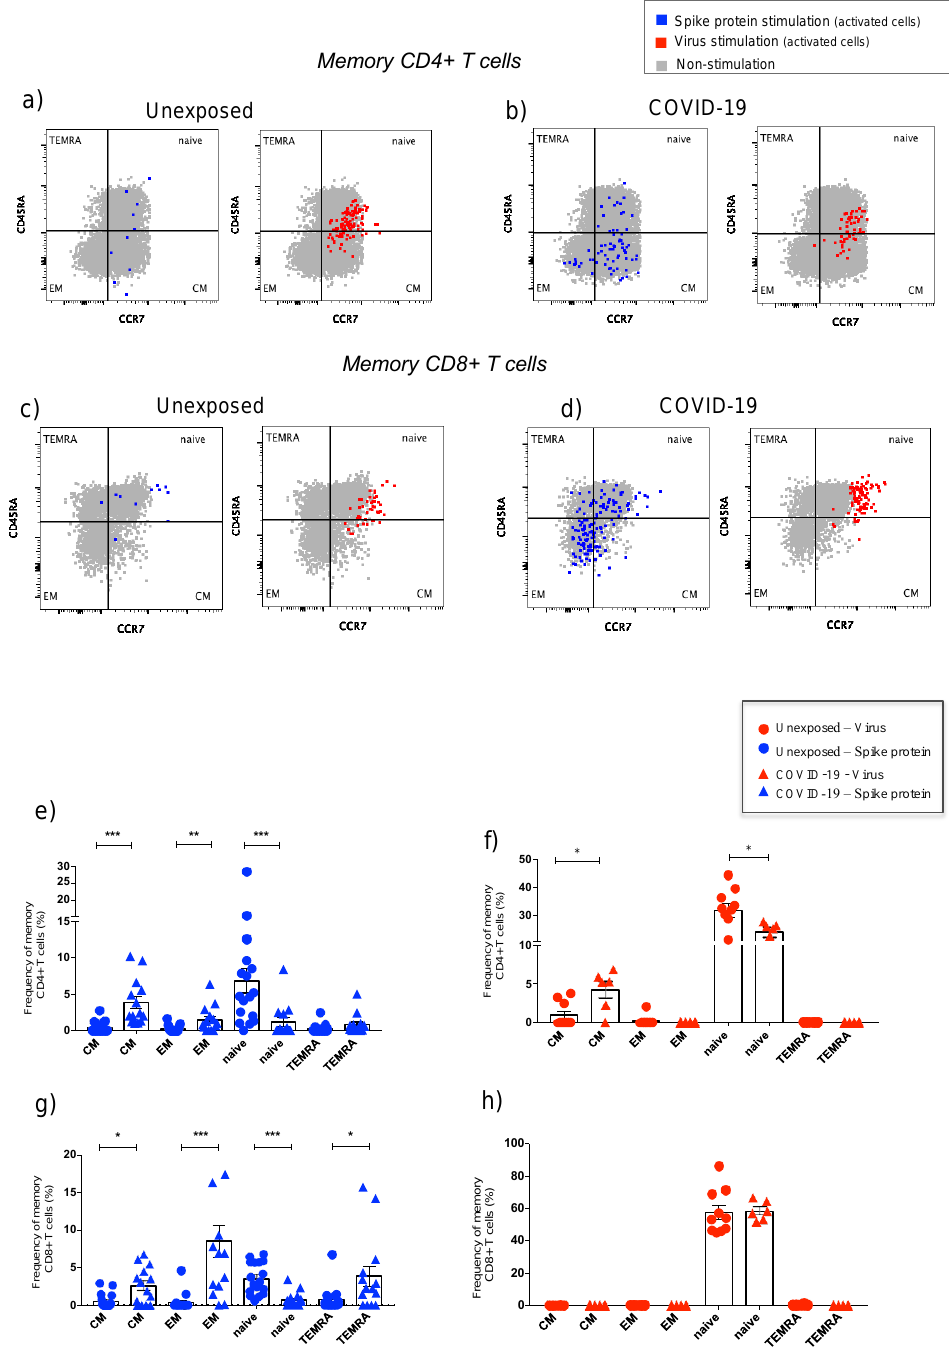
Figure 5. Memory T-cells phenotypes affected by spike protein stimulation and by live SARS-CoV-2 exposure. Percentages of memory T-cells phenotypes, as central memory (CM: CD45RA − CCR7 + ), effector memory (EM: CD45RA − CCR7 − ), naïve cells (naïve: CD45RA + CCR7 + ), and terminally differentiated (TEMRA: CD45RA + CCR7 − ) are represented ( a – h ). Total of memory T cells are in grey color (bulk: without antigen stimulation), and activated phenotype cells (CD69 + HLADR + ) are represented in blue for spike protein stimulation and in red for live virus in dot plot graphs ( a – d ). The memory CD4 + T ( e , f ) and CD8 + T cells ( g , h ) percentages from unexposed and COVID-19 are displayed by bar graphs. The final percentage value, represented by y axis, is the percentage of cells activated by SARS-CoV-2 antigens subtracted from unstimulated cells (% of cells stimulated with spike protein or virus minus % of the cells from mock condition). The data are representative of 2–5 different experiments. Symbols legend represents each sample collected from each volunteer. * p < 0.05, ** p < 0.01, and *** p <